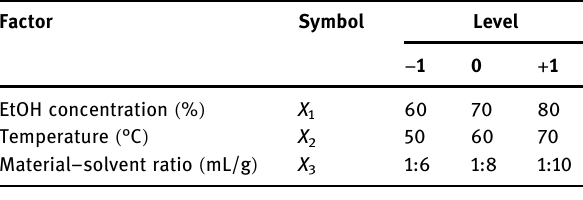
Table 1: Experimental conditions for the rates used in the trial Factor Symbol